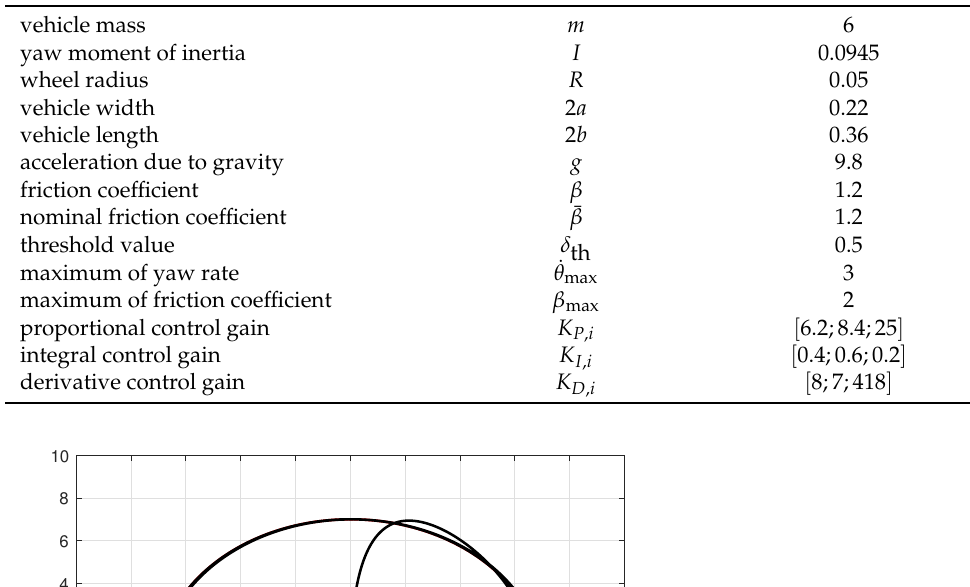
Table 3. Parameter information used in the simulation.